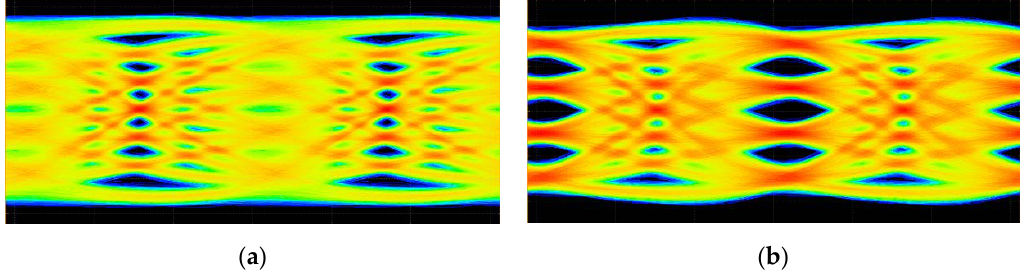
Figure 3. ( a ) Closed 4-level pulse amplitude modulation (PAM4) eye without pre-compensation, ( b ) open PAM4 eye with pre-compensation.